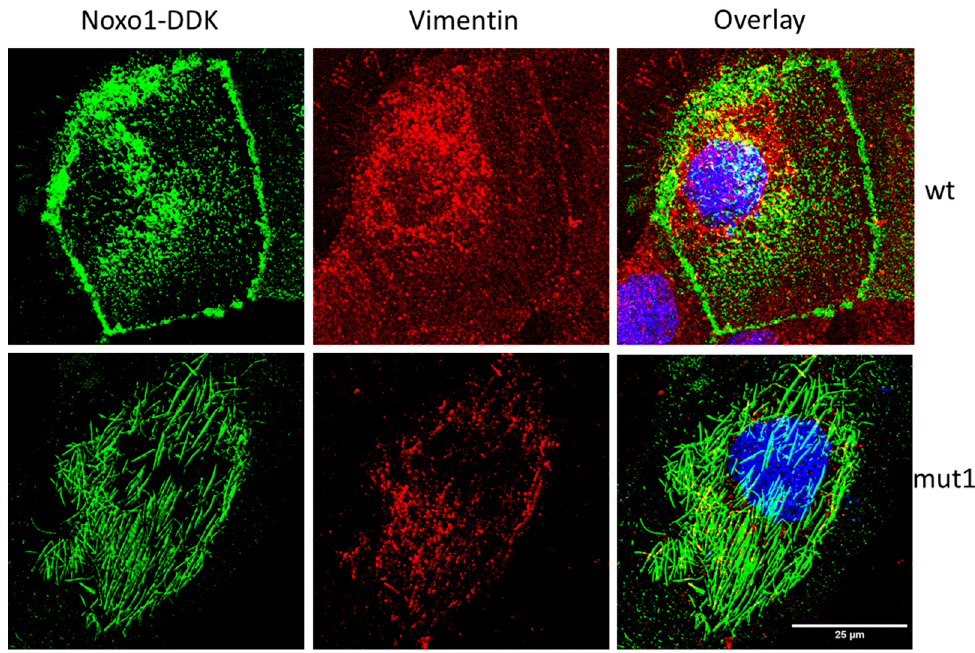
panel, red). The overlay upper right panel corresponds to wt Noxo1-DDK/PDI. Immunofluores- cence mut1 Noxo1-DDK (left lower panel, green) and PDI (middle lower panel, red). The overlay (right upper panel) corresponds to mut1 Noxo1-DDK/PDI. There is no clear colocalization of Noxo1 with calreticulin or PDI for either the wt or mut1 form of Noxo1 since most of the cells that display high noxo1 staining are lightly stained for calreticulin or PDI, suggesting that Noxo1 is not seques- trated in the ER. Scale bars: 50 μ M in all panels.